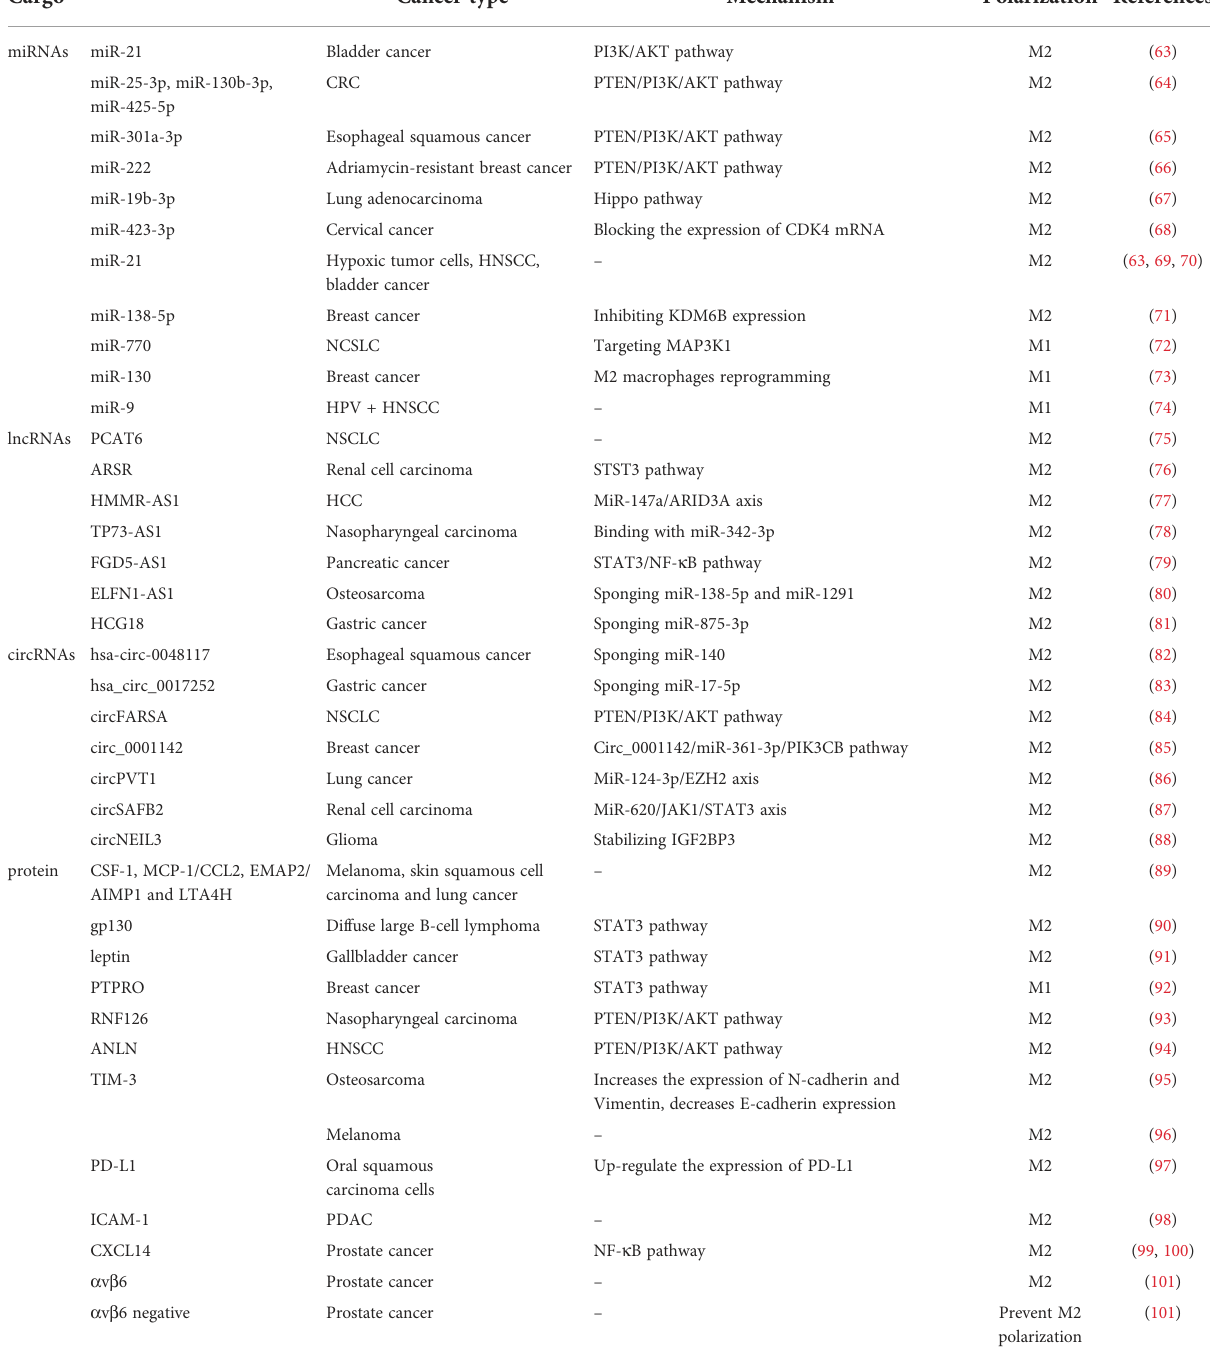
TABLE 1 Cargoes of TDEVs in promoting the polarization of